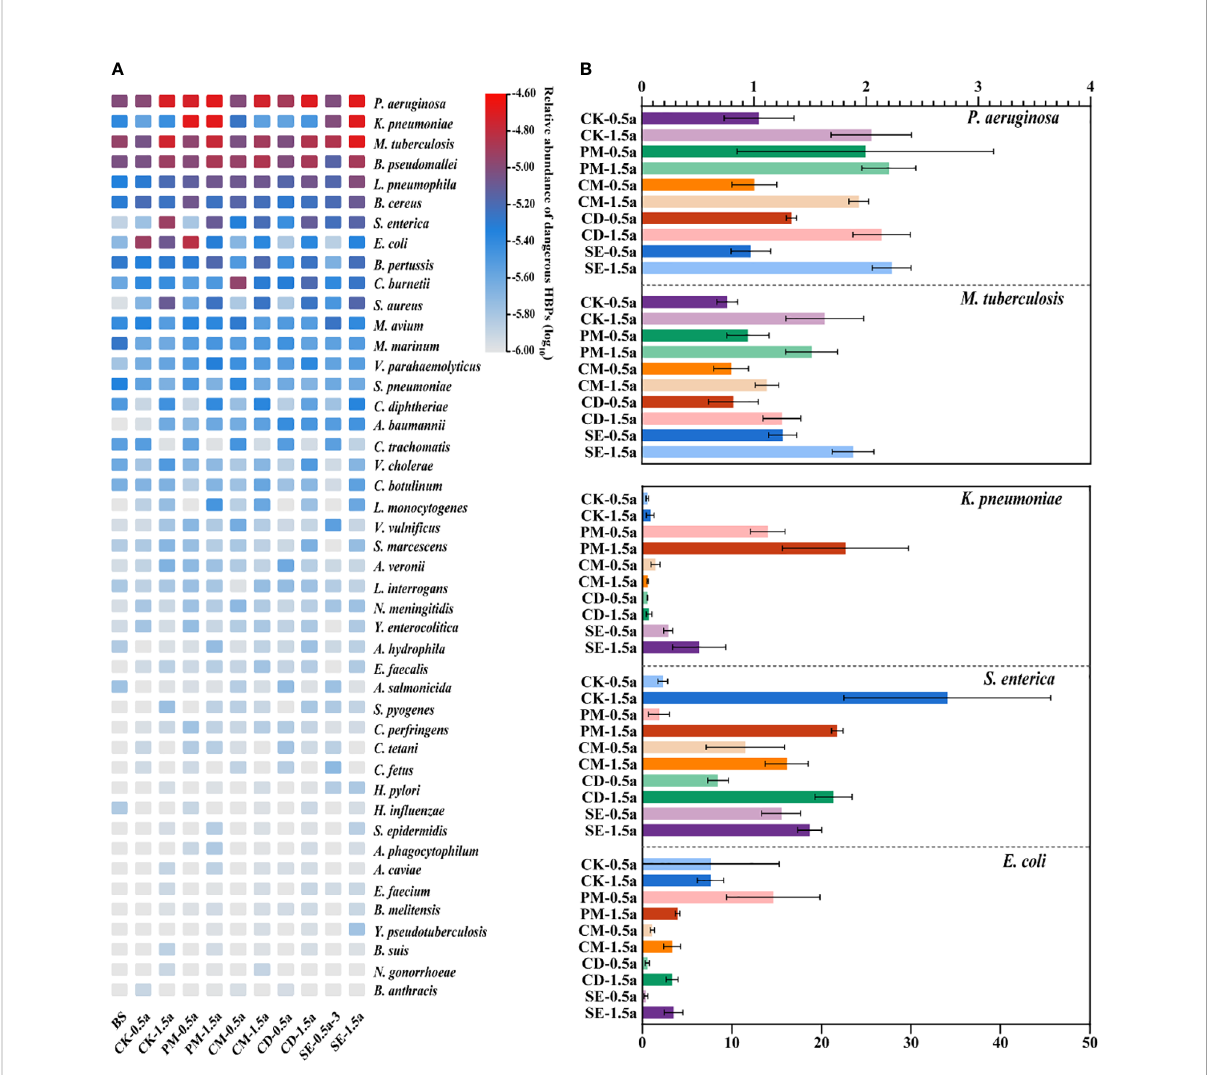
FIGURE 4 Persistence of dangerous human bacterial pathogens (HBPs) among all samples. (A) Abundance of 54 dangerous HBPs in different soil samples. (B) Fold changes of the dangerous HBPs [signi fi cantly different from background soil (BS)] compared with the